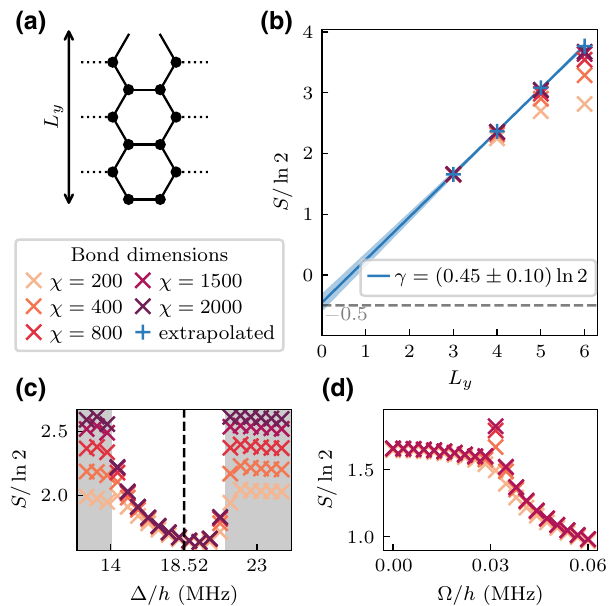
FIG. 3. The scaling of the entanglement entropy. (a) The unit cell used for infinite-DMRG calculations. We vary L y from 3 up to 6 (i.e., a maximum of 24 sites) and apply periodic bound- ary conditions in the y direction. In the x direction, the unit cell repeats, forming an infinite cylinder. (b) The area-law behavior of the entanglement entropy for an equal bipartition of the infinite cylinder and different cylinder circumferences. Bond dimensions χ up to 2000 are used to extrapolate the entropy for χ → ∞ (see Appendix C), from which the topological entanglement entropy γ = ( 0.45 ± 0.1 ) ln 2 is then determined. The error is estimated by calculating γ for the entropies S (χ = 2000 ) and corresponds to the shaded blue region. (c) The entanglement entropy for a varying energy difference (cid:3) . The phase transition from the topo- logical phase into a gapless phase (shaded gray) is signaled by the divergence of the entanglement entropy for an increasing bond dimension. The dashed line indicates the proposed experimental value (cid:3)/ h = 18.52 MHz for the realistic setup. (d) The entan- glement entropy for a varying Rabi frequency (cid:12) as required for adiabatic preparation. The gap closing is identified by a diverg- ing peek in the entanglement entropy and determines the critical value (cid:12) c / h = 0.032 MHz. As the particle number is no longer fixed, we set the chemical potential μ/ h = − 1.84